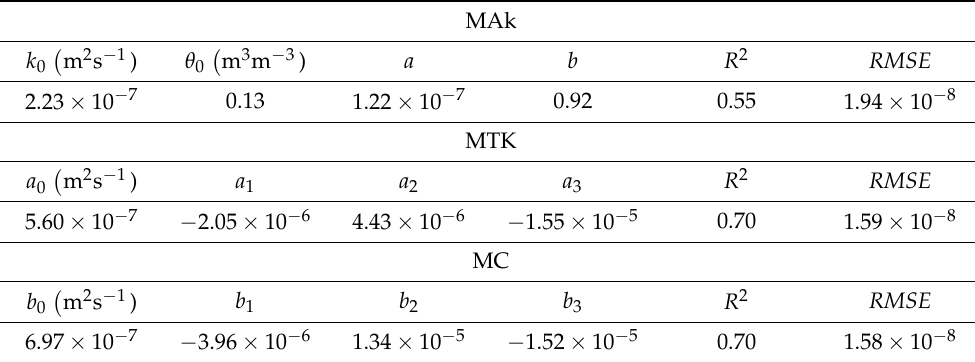
Figure 6. Daily thermal diffusivity, obtained by MN γ ( k N − 0.05 m compared to: ( a ) MTK and MAk; ( b ) MC and MTK. Table 5. Estimated parameters from Arkhangel’skaya (MAk), Tikhonravova and Khitrov (MTK) and Cubic Polynomial function (MC) models.